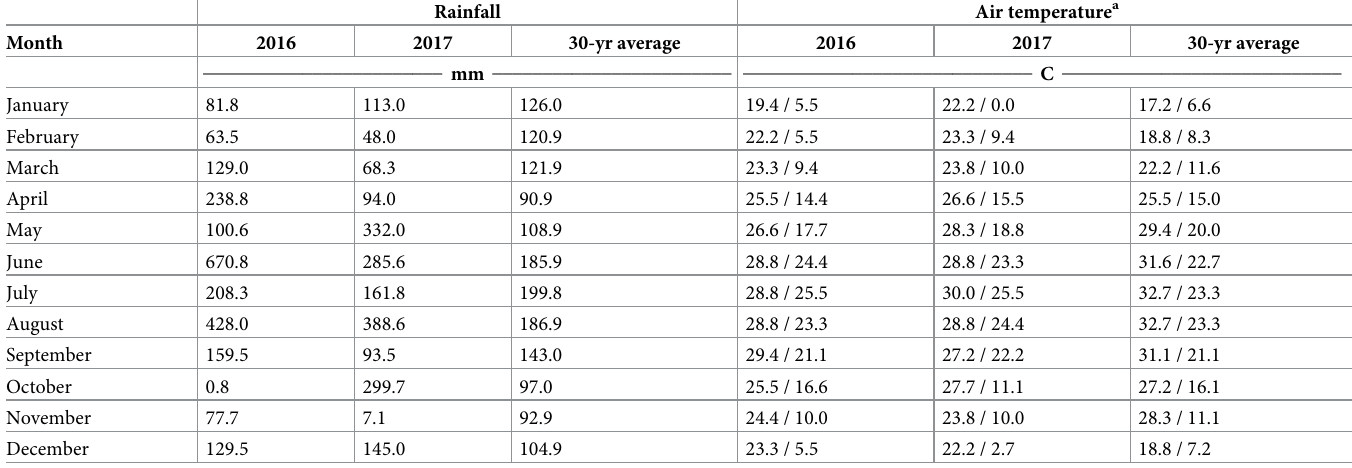
Table 1. Monthly rainfall (mm) and average monthly maximum and minimum air temperatures (C) at Schriever, Louisiana from January 2016 through December 2017 in comparison to the 30-yr